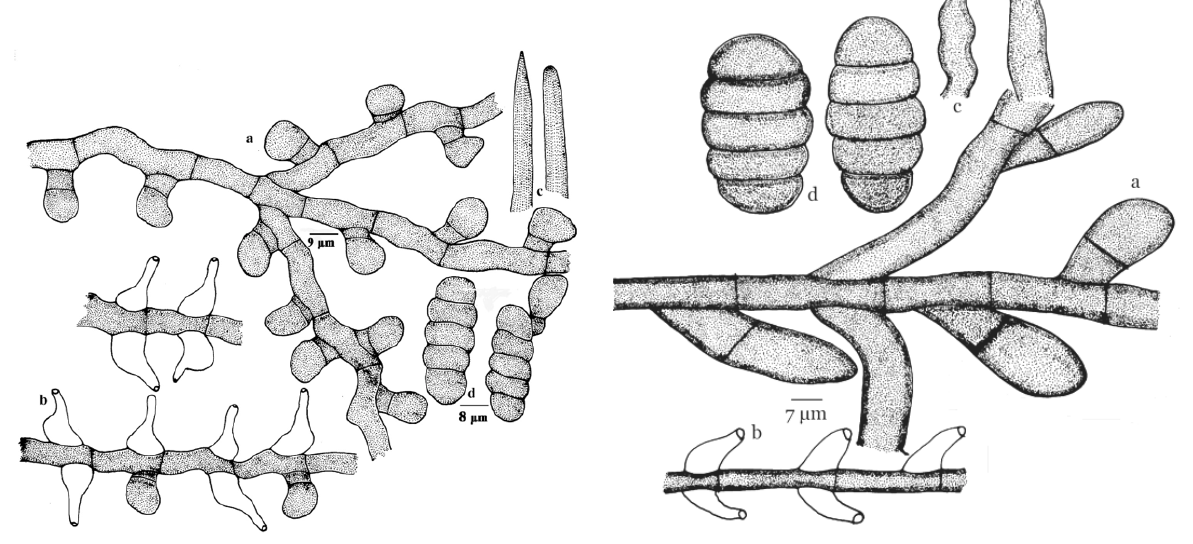
Figure 56. Meliola canavaliae a - Appressorium; b - Phialide; c - Apical portion of mycelial setae; d - Ascospores